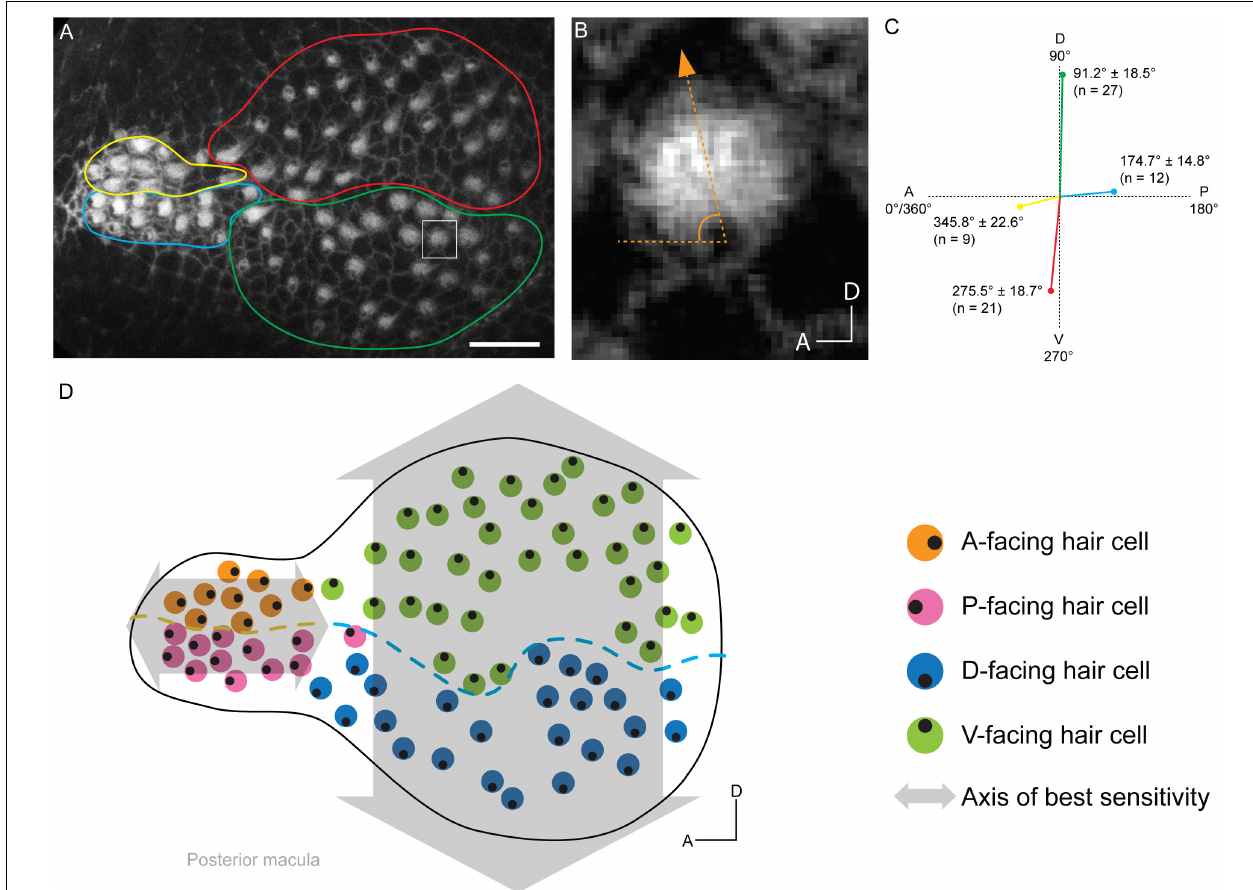
FIGURE 3 | Map of hair bundle polarities in the posterior macula of a 7-dpf larva. (A) Confocal image of a single posterior macula labeled with phalloidin. Circumscribed regions contain groups of hair cells with particular hair bundle polarities: yellow – anterior, blue – posterior, red – ventral, and green – dorsal. (B) Enlarged view of a hair bundle in square in panel (A) . The hair bundles angle of deviation from the A-P axis is depicted. (C) Posterior macula hair bundle polarities and associated hair cell numbers. Each colored line length represents the number of hair cells with that orientation in each group from panel (A) . Each line orientation is the mean deviation from the A-P axis ± SD. (D) Map of hair bundle polarities in the posterior macula from panel (A) . Each color circle represents an individual hair cell, and the black dot within represents the position of the kinocilium, which reflects bundle polarity. Lines of polarity reversal are shown in the bulbus (blue dashed line) and narrow region (yellow dashed line) for D-V-facing and A-P-facing hair cells, respectively. Axes of best sensitivity are depicted by gray